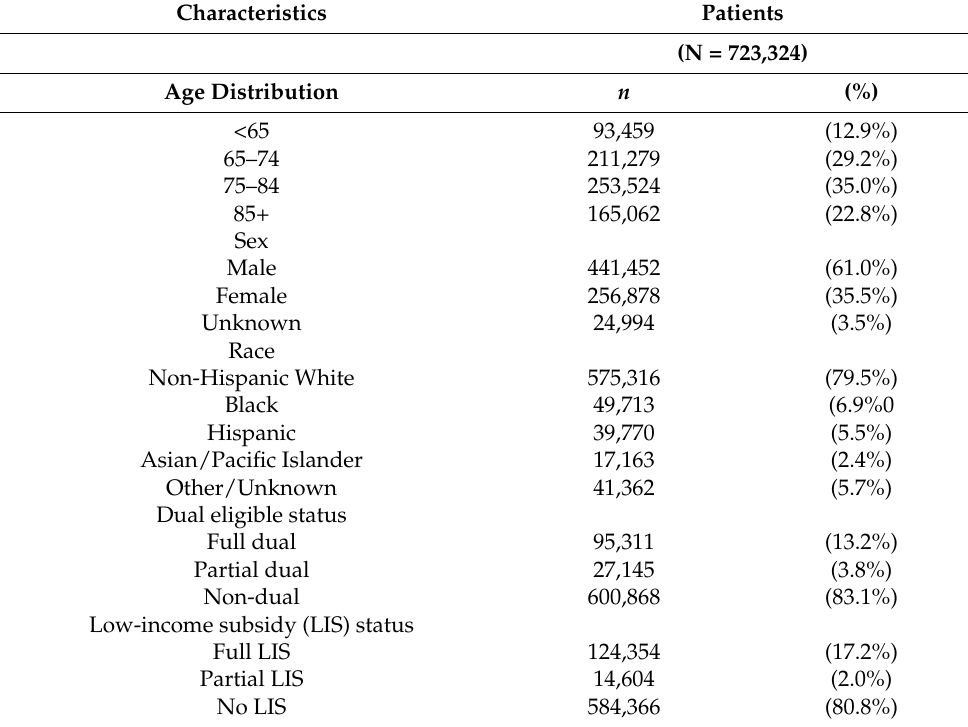
Table 1. Baseline demographic and clinical